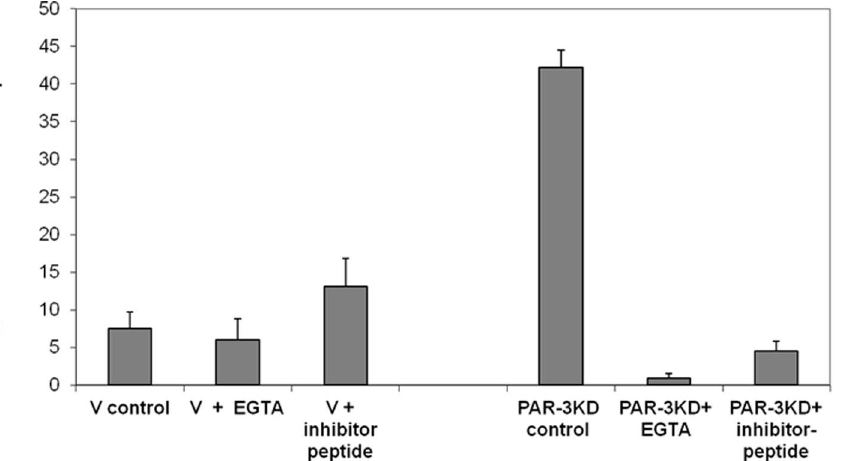
Figure 7. The effect of E-cadherin inhibition on adhesion. Vector-control or PAR-3 KD cells were plated in 96-wells clusters at 25,000 cells/well and allowed to adhere for 30 min. EGTA (5 mM) or HAV inhibitor peptide (1 mM) were added at time